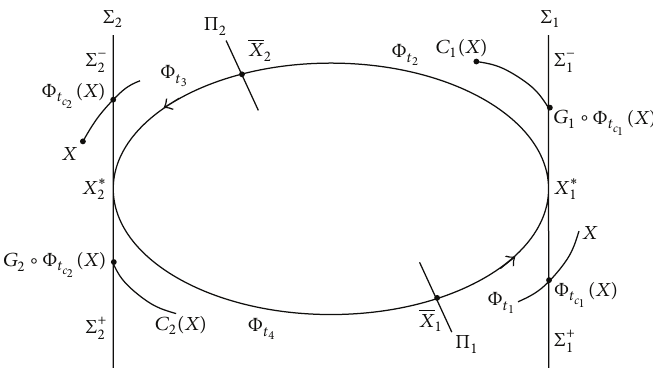
Figure 5: The schematic figure of the discontinuity mappings 𝐶 1 and 𝐶 2